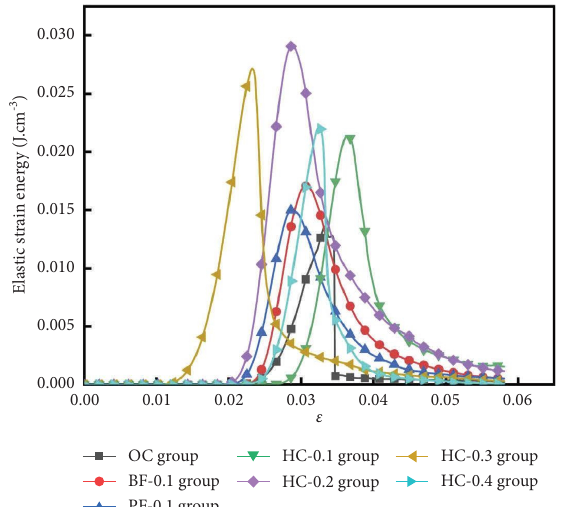
Figure 7: Evolution law of dissipative energy.